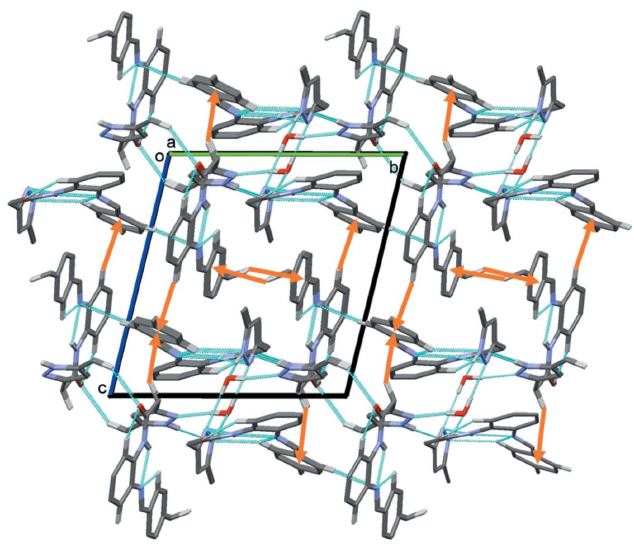
Figure 4 A view along the a axis of the crystal packing of the title compound. The hydrogen bonds are shown as dashed lines and the C—H (cid:2)(cid:2)(cid:2) (cid:2) interactions as orange arrows (see Table 1).